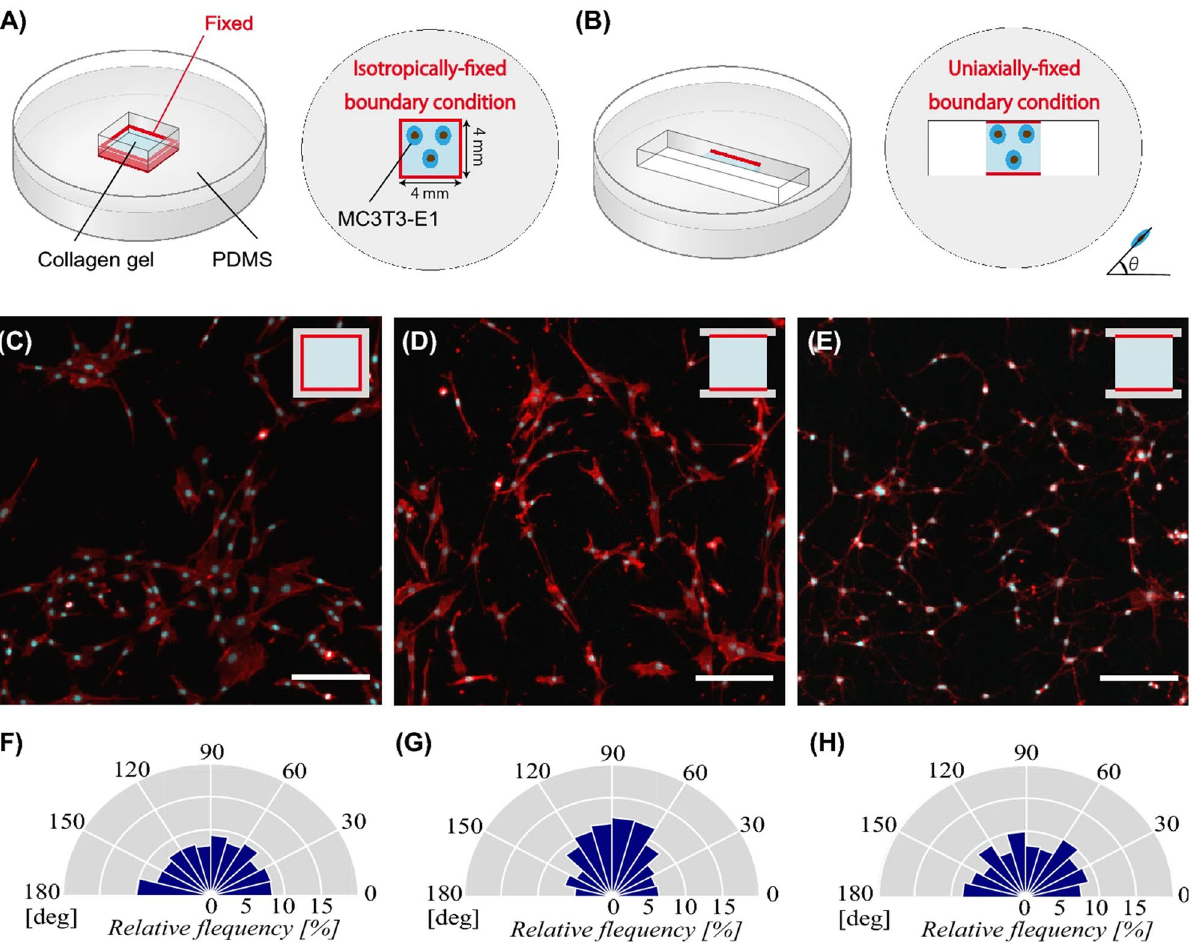
Figure 1. Schematic illustration of 3D collagen in vitro systems, ( A ) all-side fixed matrix and ( B ) 2-side fixed matrix, used to exert the isotropically- and uniaxially-fixed mechanical boundary condition, respectively. Images of DAPI and ACTIN staining of osteoblast-like cells cultured on ( C ) all-side fixed matrix and ( D ) 2-side fixed matrix for 1 day. ( E ) Images of DAPI and ACTIN staining of cells cultured on the 2-side fixed matrix for 1 day in the presence of blebbistatin. The ratios of cellular alignment of ( C ), ( D ), and ( E ) are depicted in ( F ), ( G ), and ( H ), respectively. Scale bars = 100